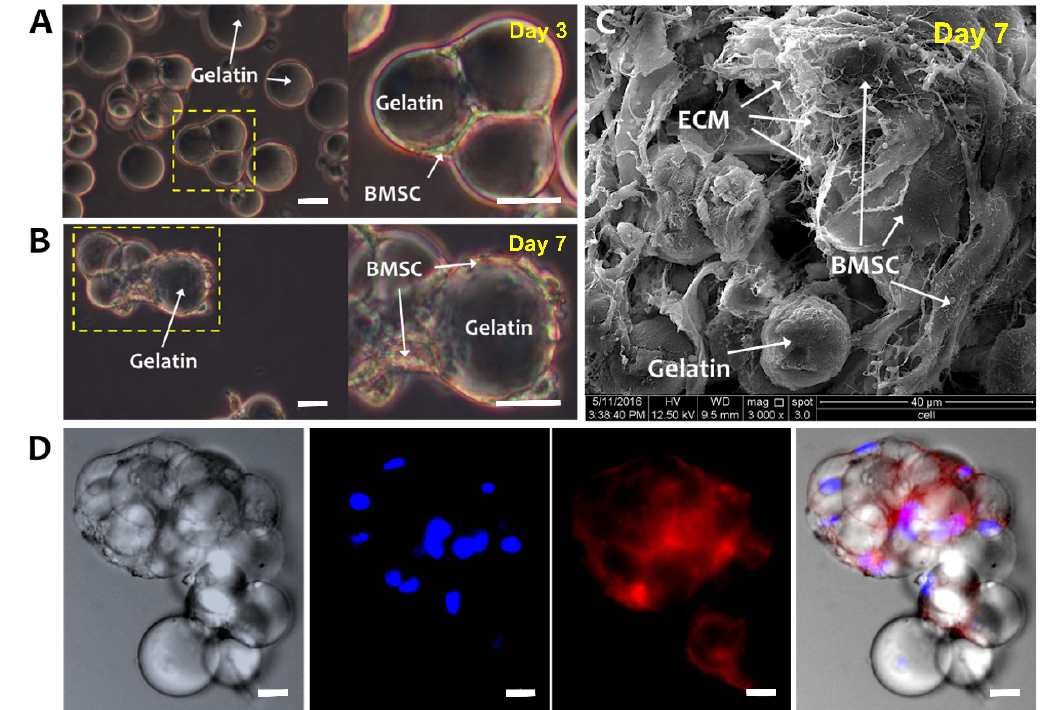
Figure 2. Bone-marrow-derived mesenchymal stem cells (BMSCs) cultured on GMs. Optical microscope images of BMSCs-GM on ( A ) Day 3 and ( B ) Day 7. White arrows were showing the bridging of adjacent GMs by elongated BMSCs, indicating cell–cell and cell–microsphere interactions. ( C ) SEM (3000× Magnification; scale bar: 40 µm) and ( D ) Confocal Laser Scanning Microscopy (CLSM) images of BMSCs-GM on Day 7. For the CLSM image, cell actin was stained with phalloidin-TRITC and nucleus with Hoechst. (Figure 2A,B,D: 100× Magnification; scale bar: 100 µm).